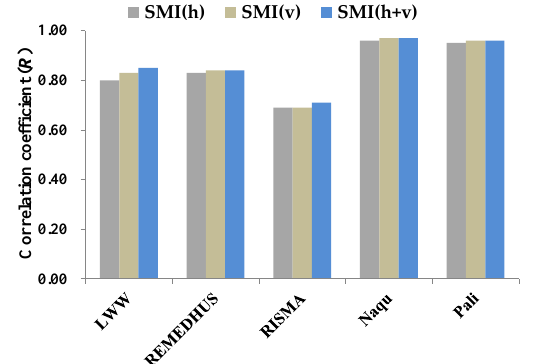
Figure 2. Correlation coefficient ( p -value < 0.05) between in situ soil moisture and SMI calculated by h-pol emissivity, i.e., SMI (h), by v-pol emissivity, i.e., SMI(v), and by combination of h-pol and v-pol emissivities i.e., SMI (h +